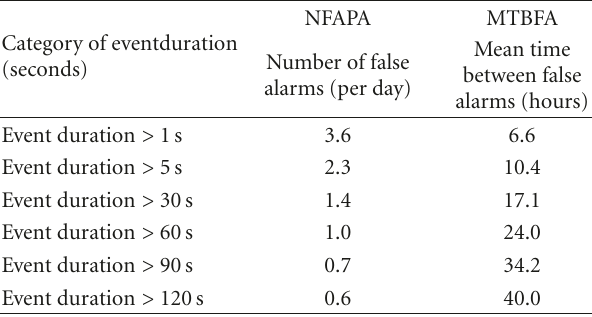
Table 3: False positive measures under varying event durations for the 31-day laboratory video sequence.